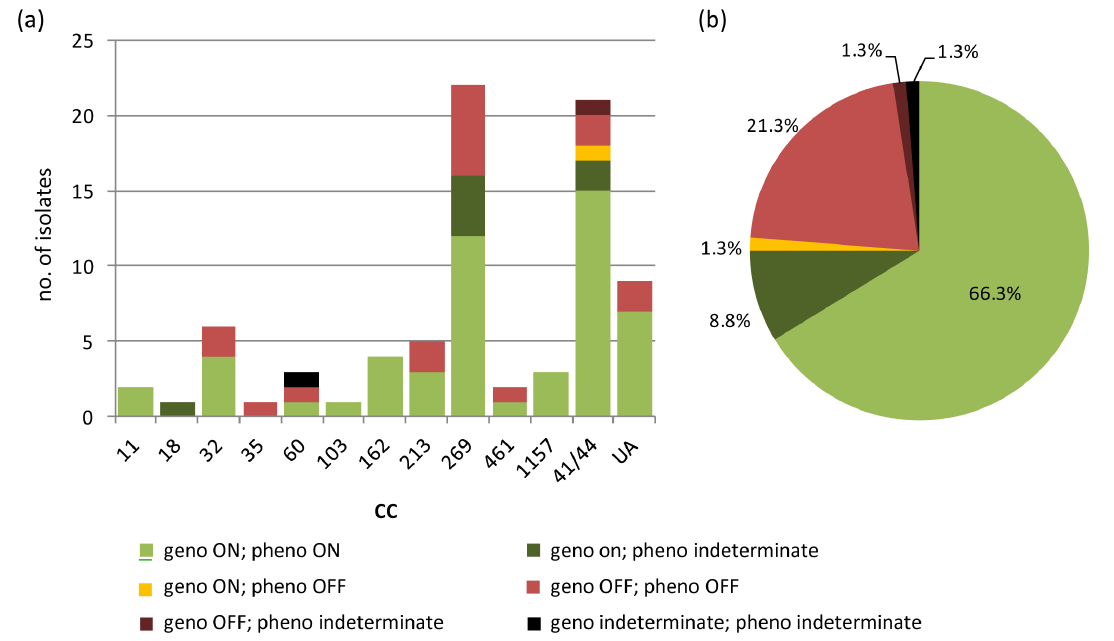
Figure 6. Distribution of the genotypic (phase variable status on/off) and phenotypic expression of at least one of the haemoglobin receptors, HmbR and HpuA, among a representative panel of English, Welsh, and Northern Irish invasive serogroup B meningococcal isolates collected from 2008–2011. geno ON= at least one receptor gene is in an ON phase variable state. geno OFF= both receptor genes are in an OFF phase variable state. pheno ON/OFF= able/unable to grow using haemoglobin as the sole iron source and therefore phenotypically expressing at least one/no haemoglobin receptor/s. geno indeterminate = genotypic phase variable state could not be determined owing to ambiguous sequence/fragment analysis. pheno indeterminate = phenotypic state could not determined owing to poor growth on MH agar or uncertainty regarding the status of the growth observed (isolate in ON configuration vs relatively large number of ON phase variants against an OFF background). The single isolate with a geno ON pheno OFF status possessed a nonsense mutation downstream of the homopolymeric tract. UA= unassigned STs.